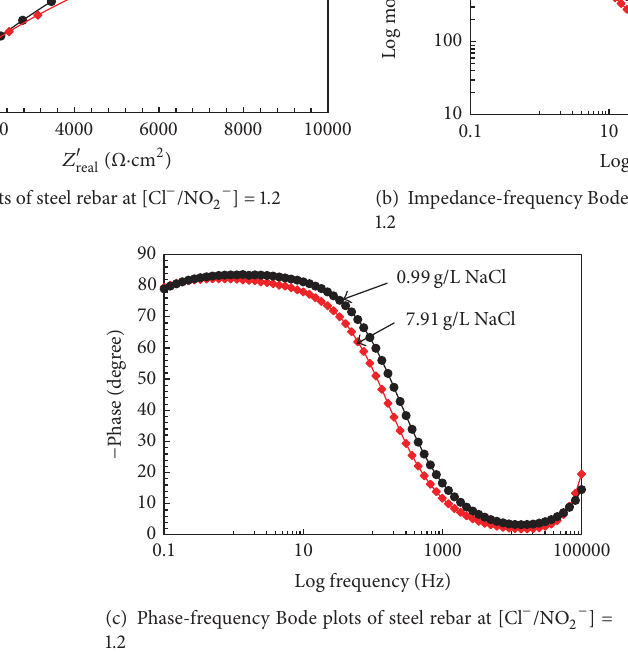
Figure 6: Electrochemical plots of steel rebar exposed in saturated Ca(OH) 2 solution with different concentrations of NaCl at [Cl − /NO 2− ] =